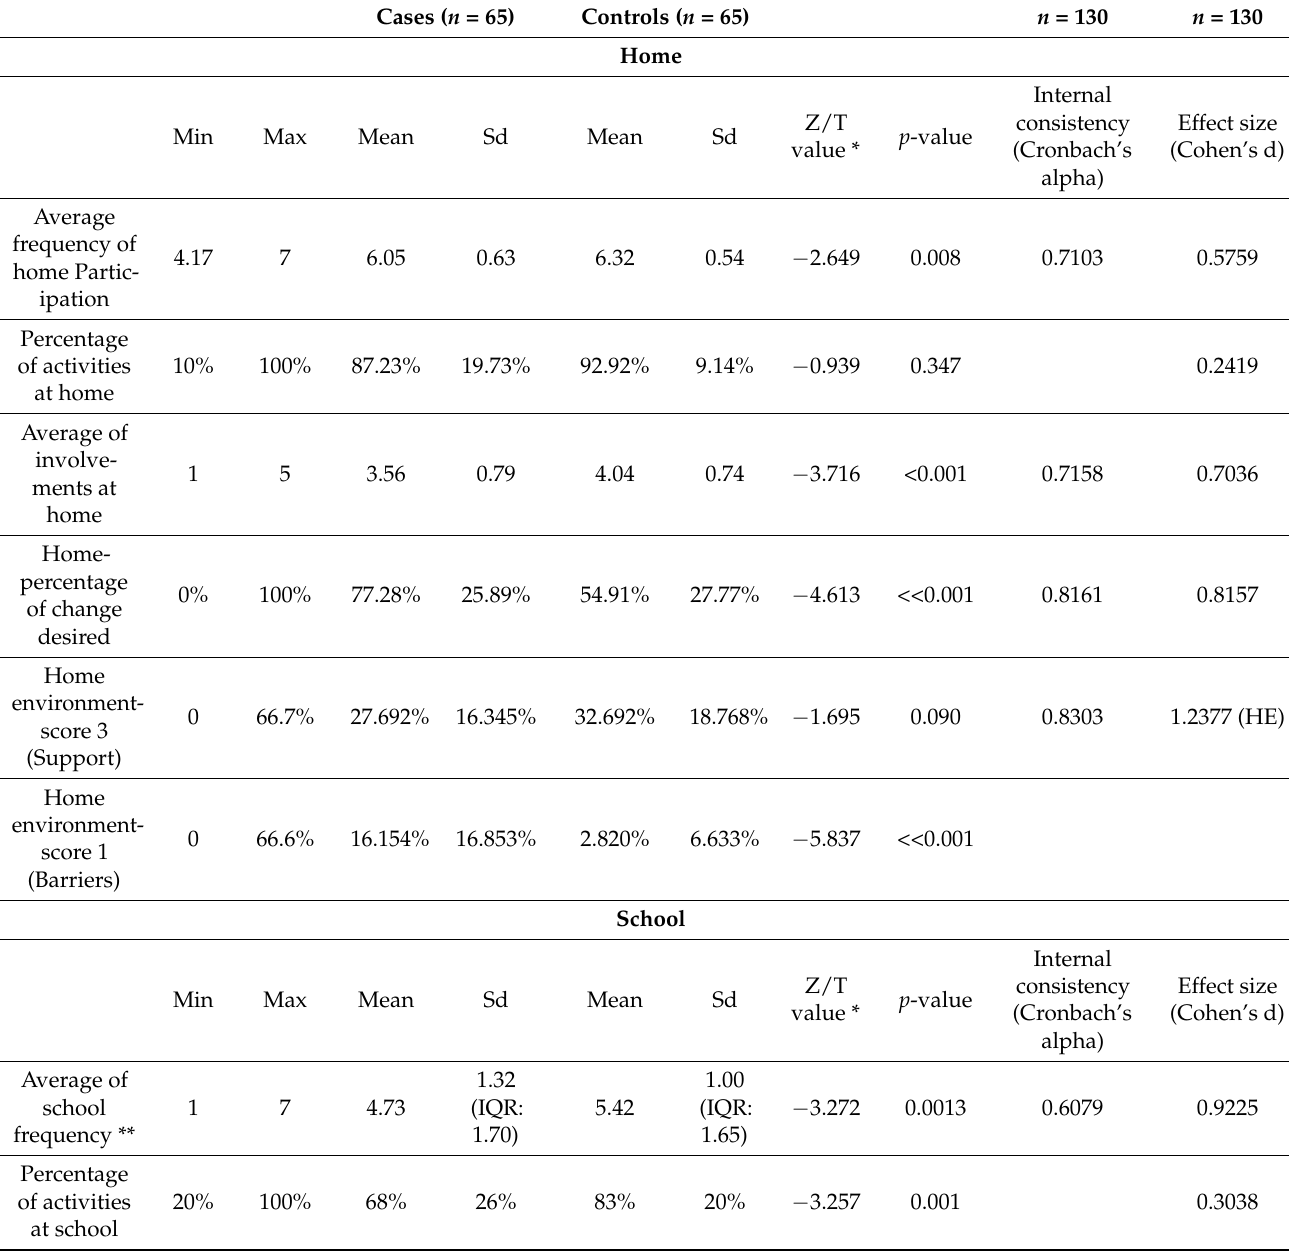
Table 4. Group summary scores of children with (cases) and without disabilities